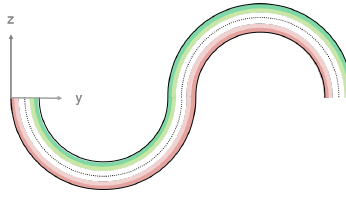
Figure 10: Stress distribution in a corrugated laminate of "infinite width" subjected to torsional